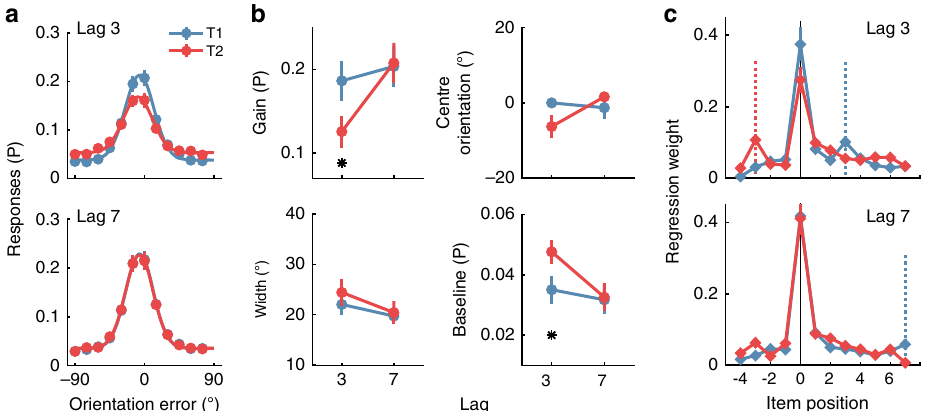
Fig. 4 Behavioural results for the RSVP task in Experiment 2. a Aggregate response accuracy across participants (difference between presented and reported orientations) for T1 (blue lines) and T2 (red lines), shown separately for Lag 3 and Lag 7 trials. Lines are fi tted Gaussian functions. b Quanti fi ed behavioural responses for the four parameters of the fi tted Gaussian functions (gain, width, centre orientation and baseline) to each participant ’ s data. Asterisks indicate Bonferroni-corrected t-test differences at p < 0.05. c Regression results for the in fl uence of distractors and targets on participants ’ responses. The dotted vertical lines indicate the position of the other target (colour matched). Consider, for example, the panel depicting Lag 3 results. For T1 report, T2 occurred at item plus 3 as indicated by the dotted blue line, whereas for T2 report, T1 occurred at item minus 3, as indicated by the dotted red line. Across all panels error bars indicate ∓ 1 standard error of